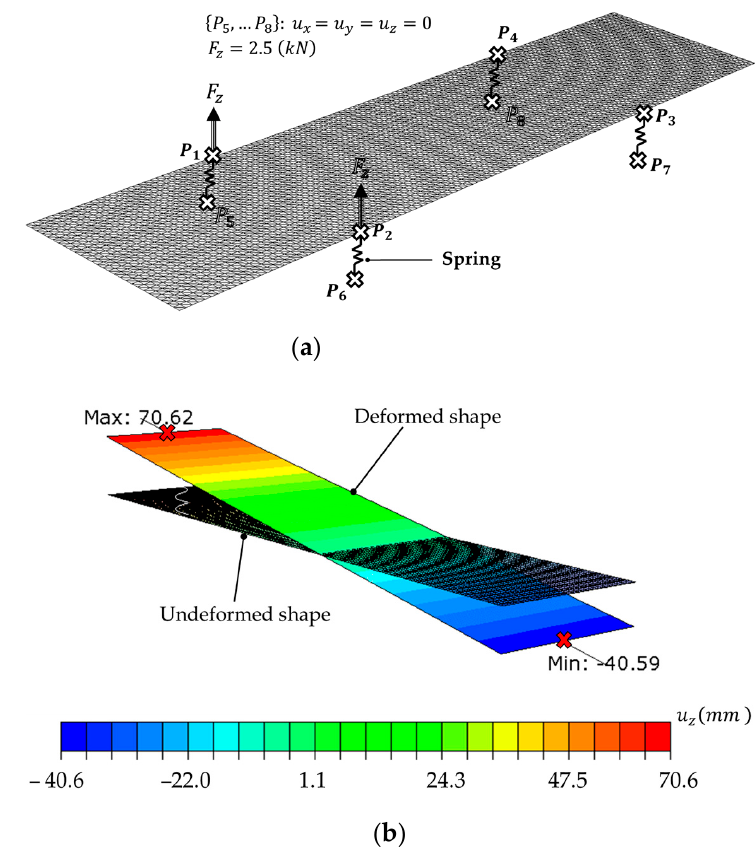
Figure 11. Steady-state dynamic analysis by FEM; ( a ) natural boundary condition and ( b ) displace- ment in z -direction at a frequency of 1.07 (Hz).